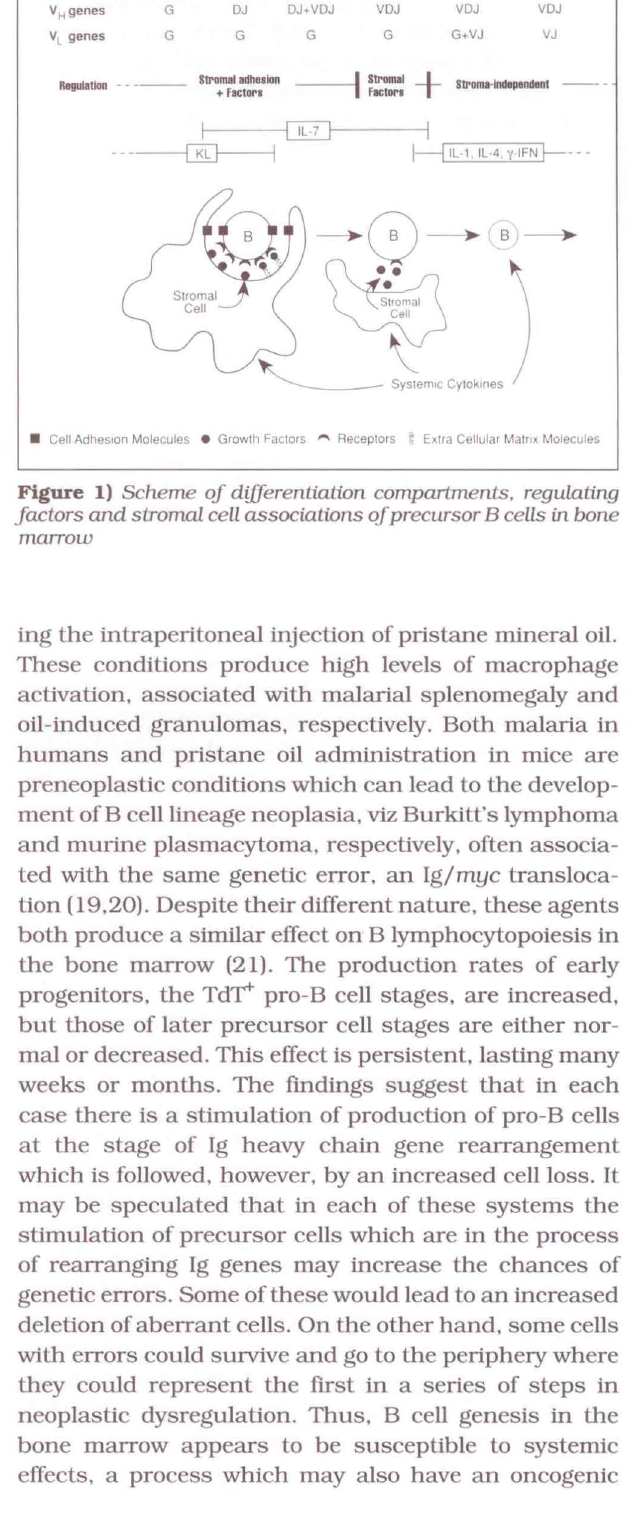
Figure I) Scheme of d!lferentiation compartments, regulating factors and stromal cell associations of precursor B cells in bone marrow